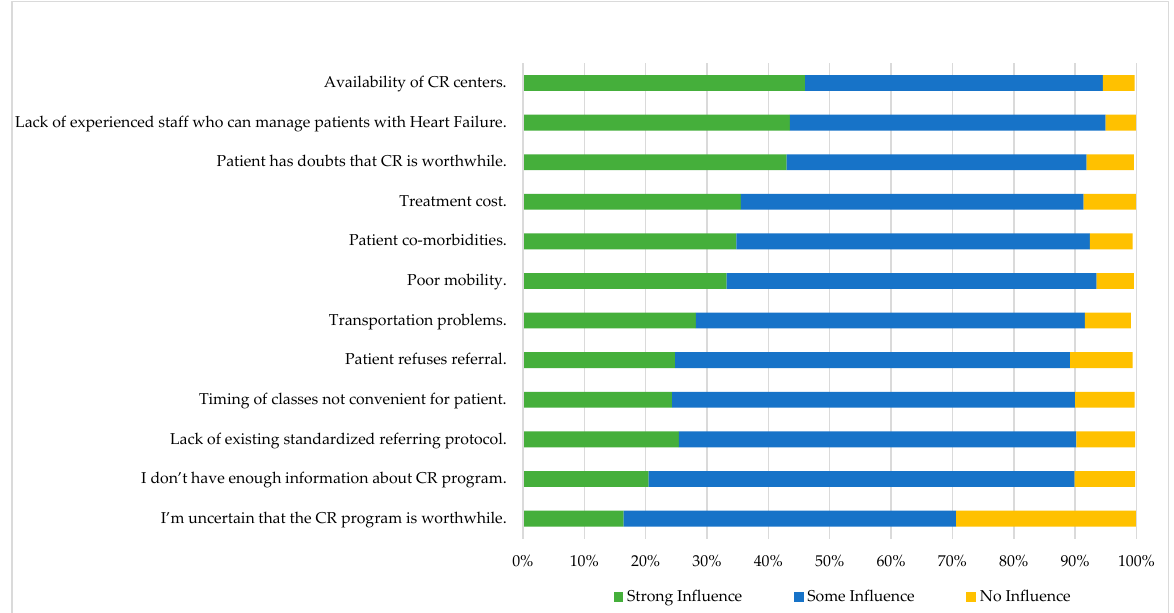
Figure 2. Barriers affecting decisions to refer patients with heart failure for cardiopulmonary reha- bilitation, using influence graded as no, some, or strong influence ( n = 1056).